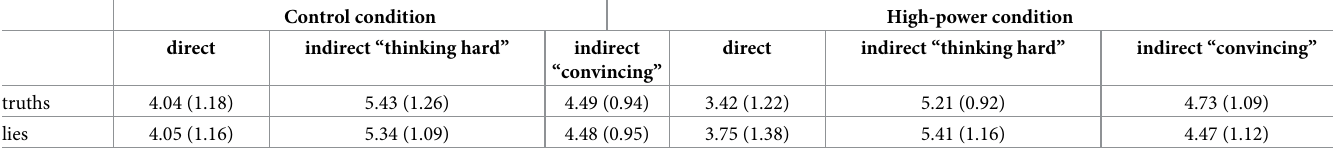
Table 3. Mean scores (with accompanying SDs) for the indirect and direct conditions as a function of power and veracity (Study